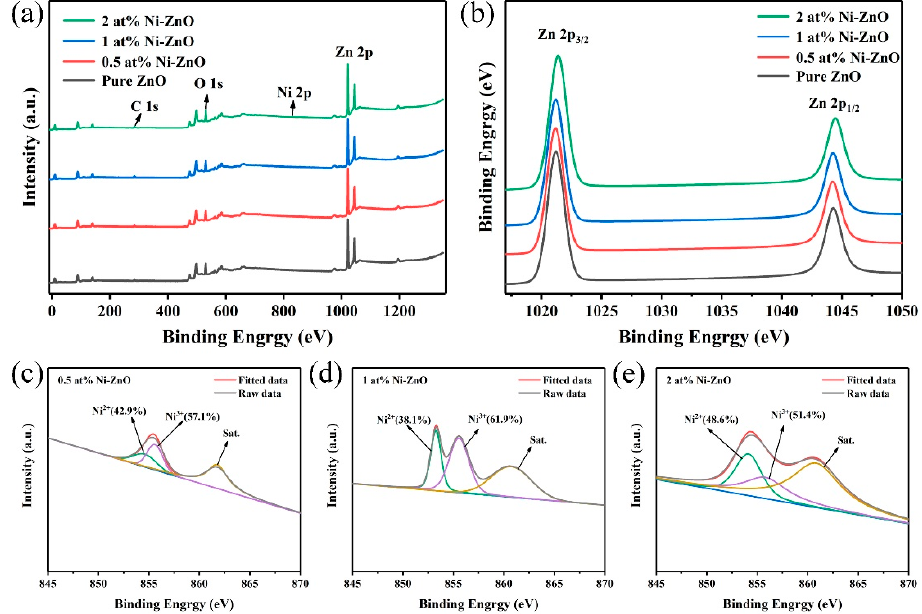
Figure 5. The XPS spectra of the pure and Ni–ZnO for ( a ) the full scan, ( b ) Zn 2p, ( c – e ) Ni 2p 3/2 of 0.5, 1, 2 at% Ni–ZnO.